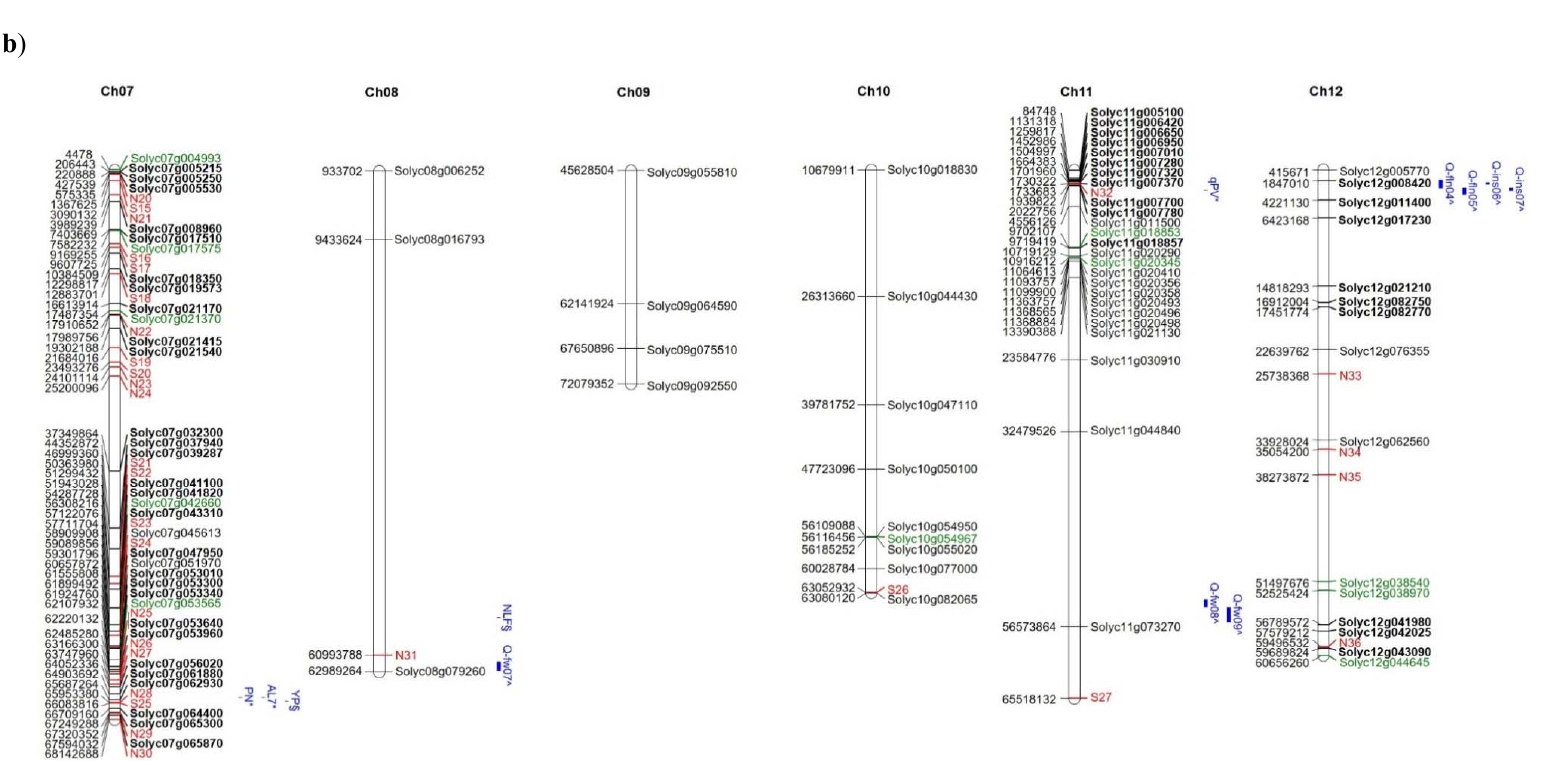
Figure 5. Distribution on the 12 tomato chromosomes of genes affected by mutations with high (green colour) or moderate (black colour) impact, ( a ) chromosomes from 1 to 6, and ( b ) chromosomes from 7 to 12. The private mutations of the genotype E42 are shown in bold, whereas, in red, are reported as the markers with alleles deriving from wild species. The position of markers/QTLs reported in the literature are shown in blue (§ from Ruggieri et al, 2019 [18] , * from Xu et al., 2017 [31] , $ from Hernandez ‐ Bautista et al., 2016 [40] , and ^ from Zhang et al., 2018 [41] ).